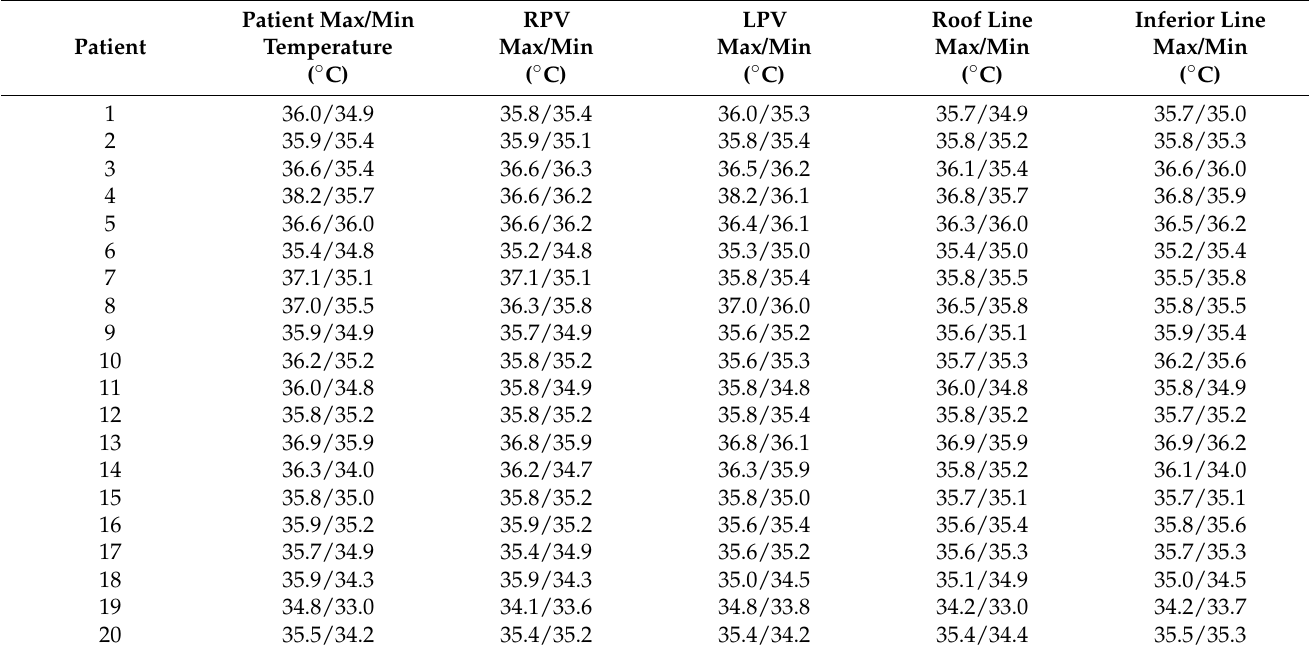
Table 2. Maximal and minimal esophageal temperatures measured.